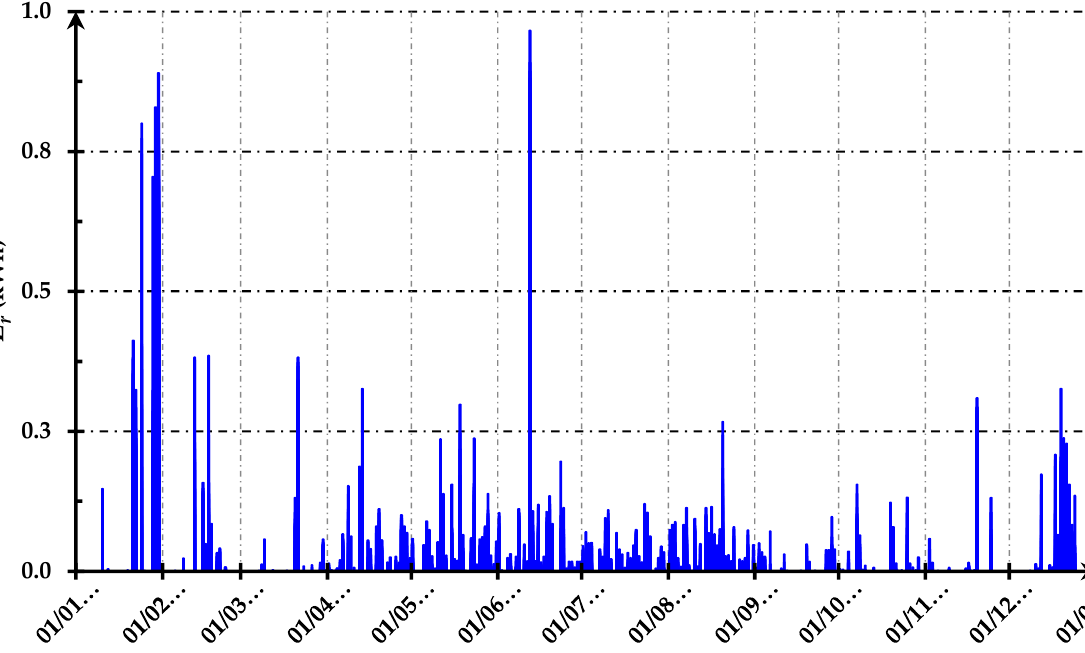
Figure 15. Active energy (Er) returned to the grid (rural power system) in 2014.